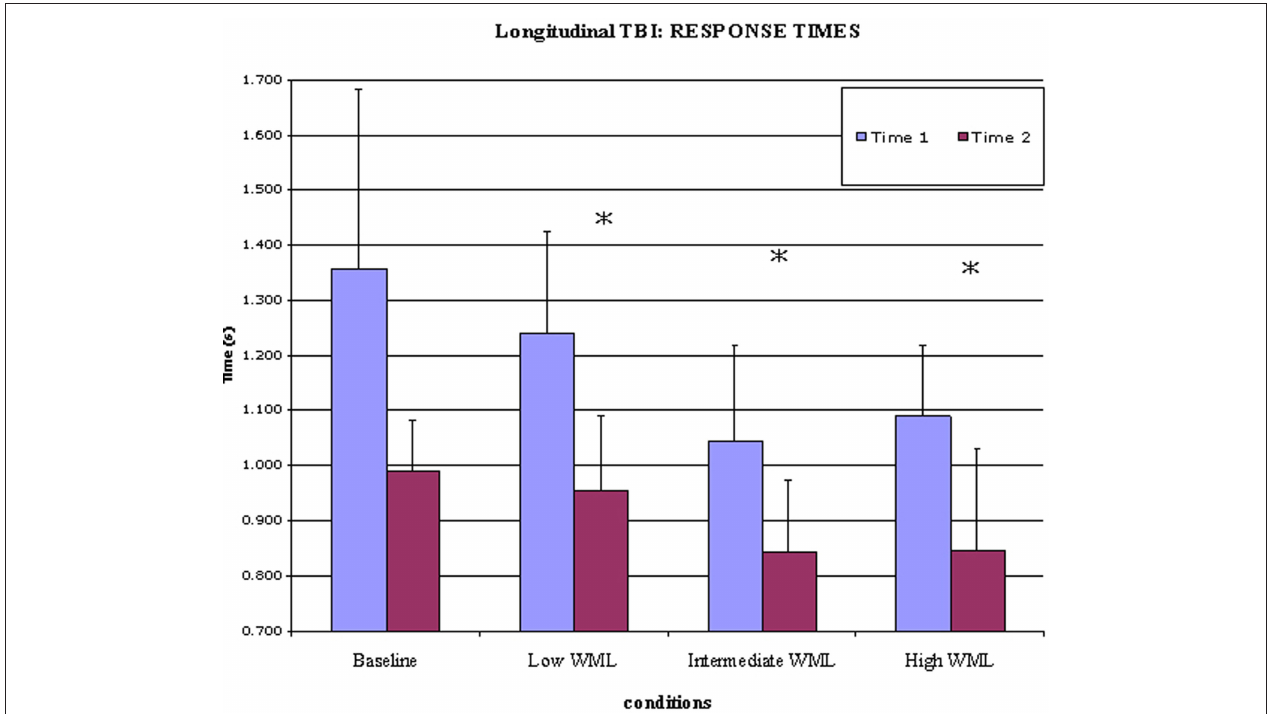
FIguRe 4 | Significant decrease of response times at Time 2 versus Time 1 in TBI patients.